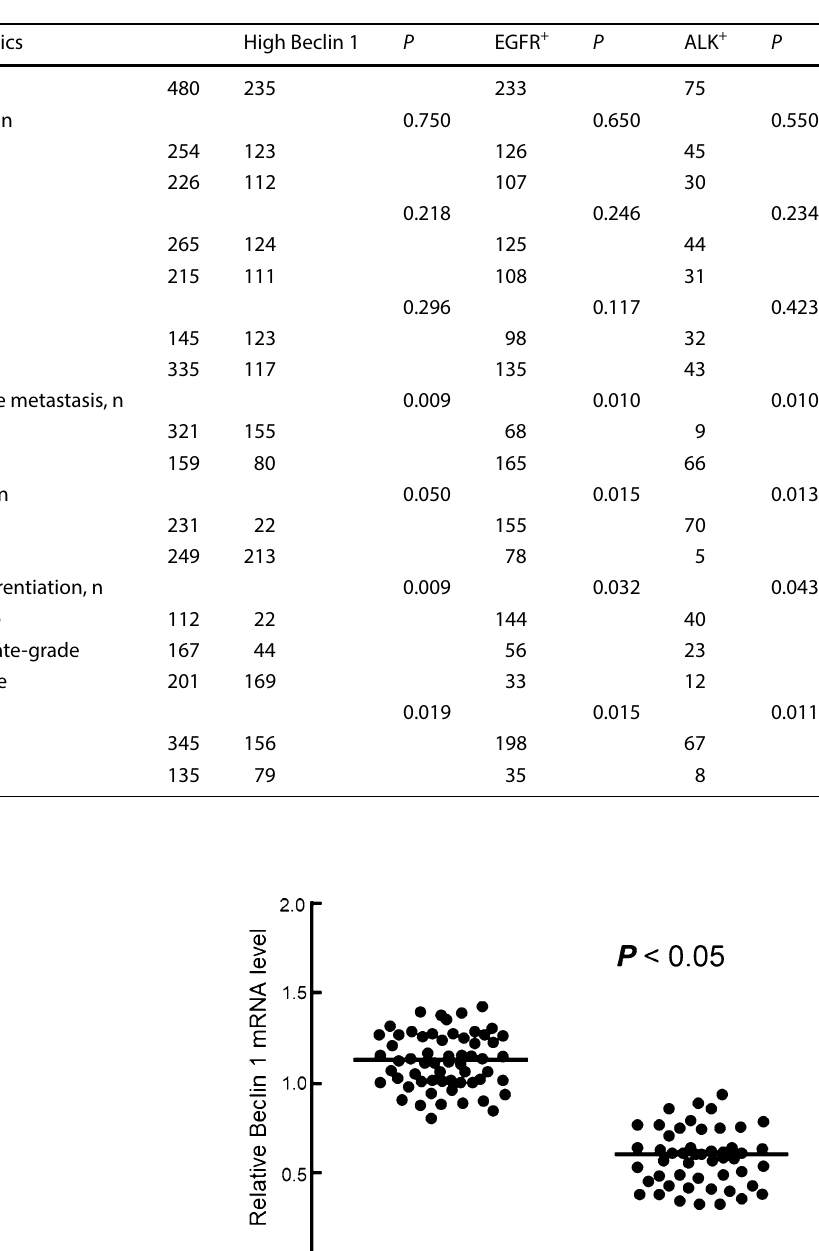
Table 2 Relationship between pathological characteristics of non-squamous non-small cell lung cancer patients and Beclin 1 expression, EGFR and ALK mutations